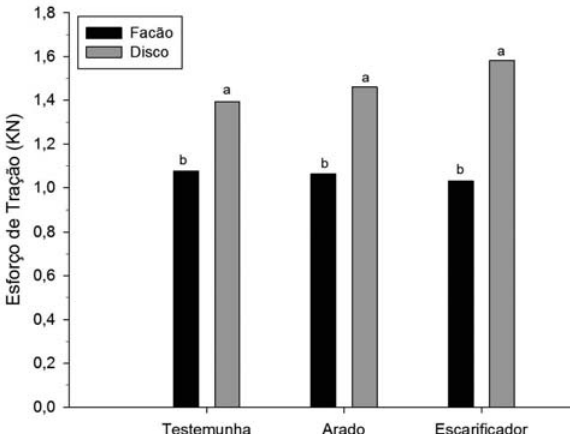
Figura 2. Esforço de tração em um Latossolo Vermelho distrófico húmico manejado sob Sistema Plantio Direto há 16 anos e submetido à aração, à escarificação e à ação de semeadora equipada com dois mecanismos rompedores de solo (discos duplos e disco + facão). Obs.: Os dados foram contrastados pelo teste de Tukey a 5 %, dentro de cada sistema de manejo do solo.